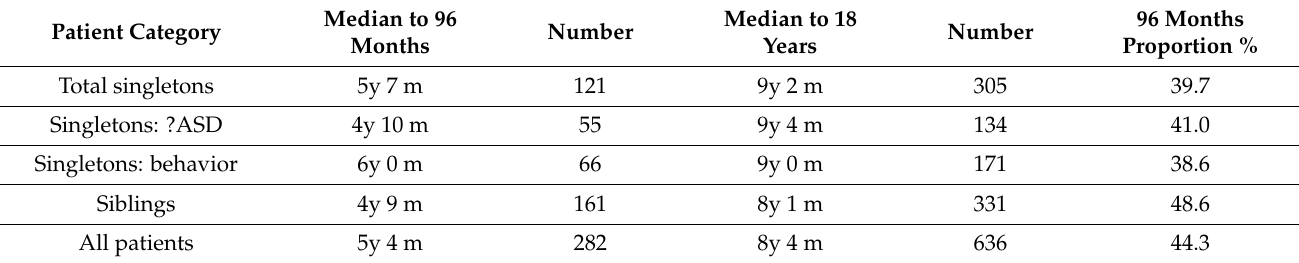
Table 1. Median times to diagnosis for each female